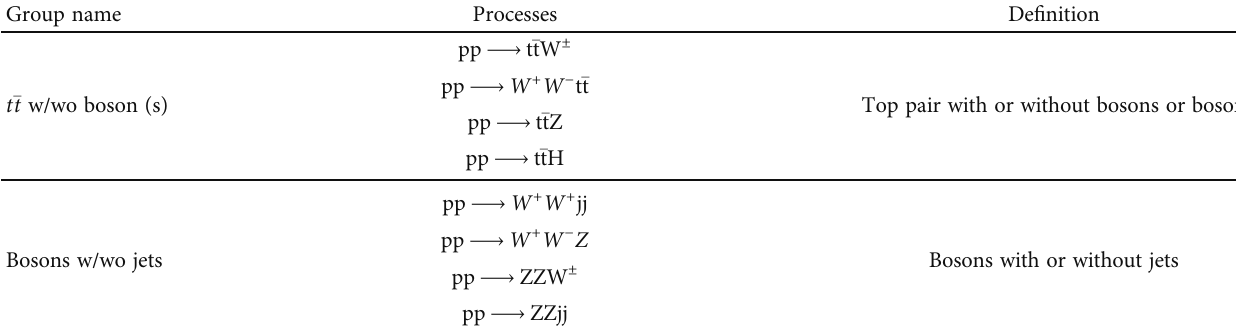
Table 3: Content of background groups: here, we grouped backgrounds to increase clarity of our histograms. The most important feature of these backgrounds are four of them includes top pair as backbone, and others only bosons. Only pp ⟶ t (cid:1) tl + l − process is left as own. That behavior of backgrounds leads us the categorization of them in this table.